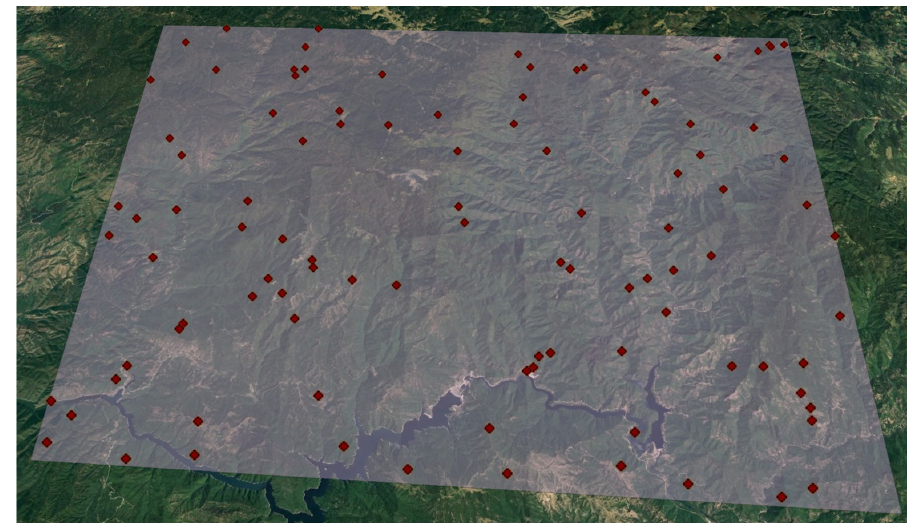
Figure 4. Study area boundaries and random points.